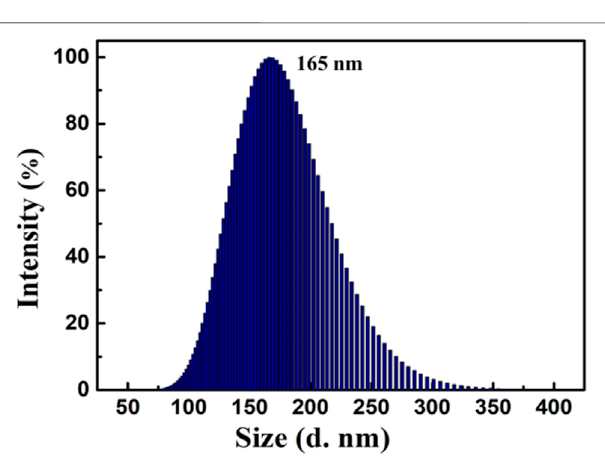
FIGURE 2 | Size distribution curve of compound 1 (2.0 × 10 − 5 mol L − 1 ) in CH 3 CN-H 2 O mixture with 90% water